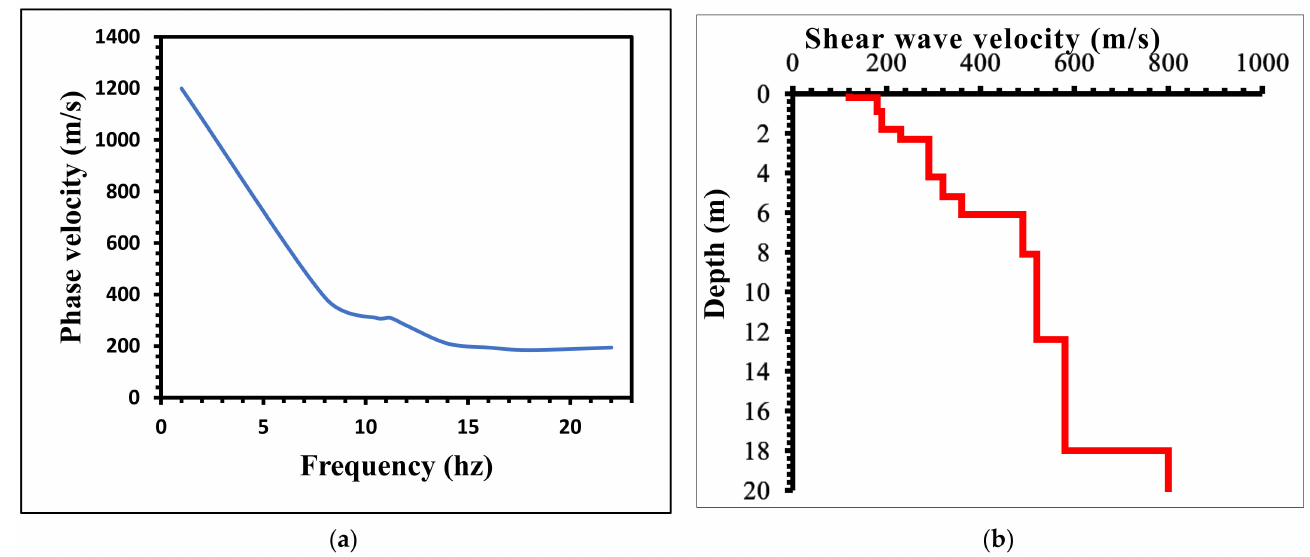
Figure 8. Multi-channel analysis of surface waves (MASW) test. ( a ) Dispersion curve, ( b ) 1D inversion analysis of dispersion